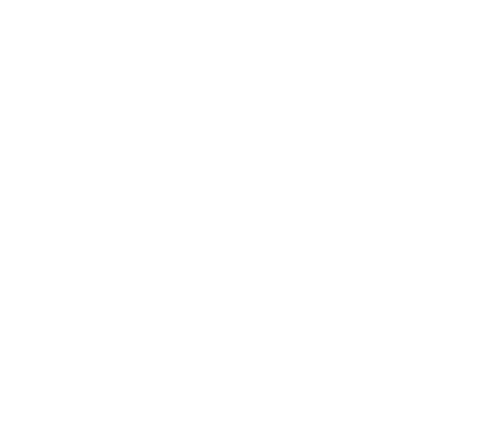
( d ) Figure 22. The effect of h / t on δ u / δ m . ( a ) n = 0.1; ( b ) n = 0.2; ( c ) n = 0.3; ( d ) n = 0.4. The value of δ u / δ m is stable at about 1.189. So the calculation formula of δ u / δ m is as follows: (cid:3083) (cid:3296) (cid:3083) (cid:3288) = 1.189 (13 ) 4.2. Simplify Restoring Force Model 4.2.1. Hysteresis Rules Through the shape analysis of the hysteresis curve obtained by the FEA calculation, it is found that when the member is in the strengthening stage, the hysteresis loop of each level displacement is a parallelogram, and the unloading stiffness and elastic stiffness are almost the same. The unloading stiffness of the member is different under different buck- ling modes when the member is in the stiffness degradation stage. Through the analysis of the hysteretic behavior of the CFTWS lipped channel beam-column member, based on the determination of the characteristic point calculation formula of the skeleton curve model and the characteristics of the hysteresis curve in different buckling modes, the im-